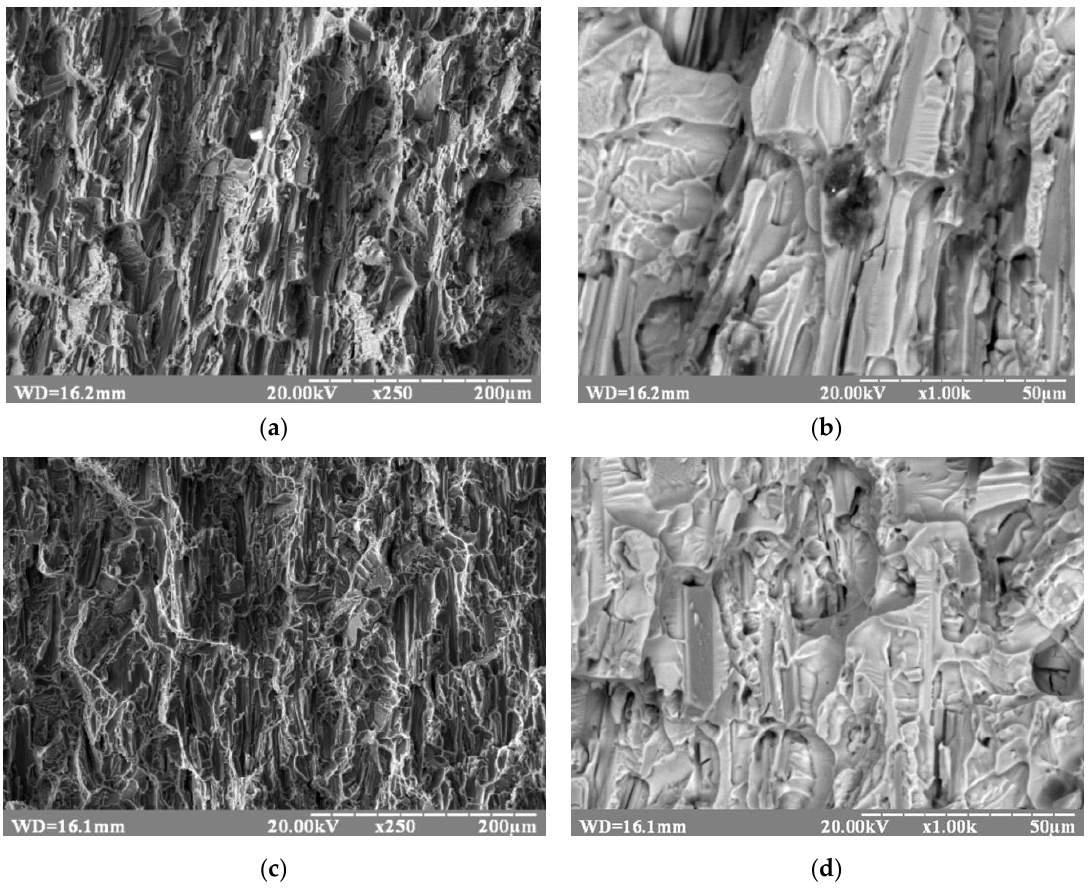
Figure 10. Structure of fracture surfaces of series 6 ( a , b ) and 7 ( c , d ) samples.